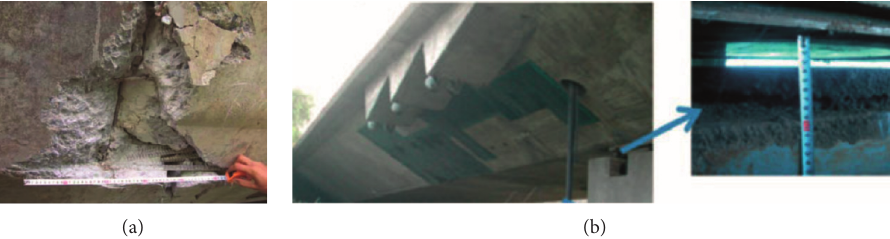
Figure 7: Damage patterns of the Tianjin Yonghe Bridge. (a) Cracks at the closure segment at both side spans. (b) Damaged concrete piers of the bridge. Adapted from “Structural health monitoring of a cable-stayed bridge with Bayesian neural networks” by Stefania Arangio & Franco Bontempi (2015), Structure and Infrastructure Engineering, 11: 4, 575–587, reprinted by permission of Taylor & Francis Ltd.